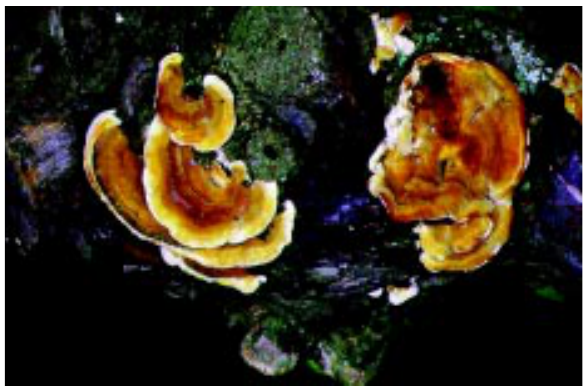
Fig. 2. Basidiocarps of Trametes versicolor on the trunk of a diseased vine.